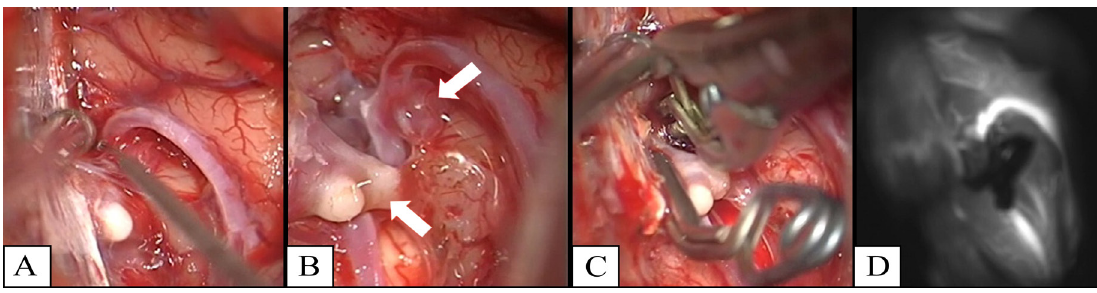
Legend: A – The pia mater was carefully dissected and the pericallosal artery was exposed. B – Both aneurysms at the bifurcation of the anterior cerebral artery into the pericallosal and callosomarginal arteries are visible (arrows). C – Subsequently, their necks have both been